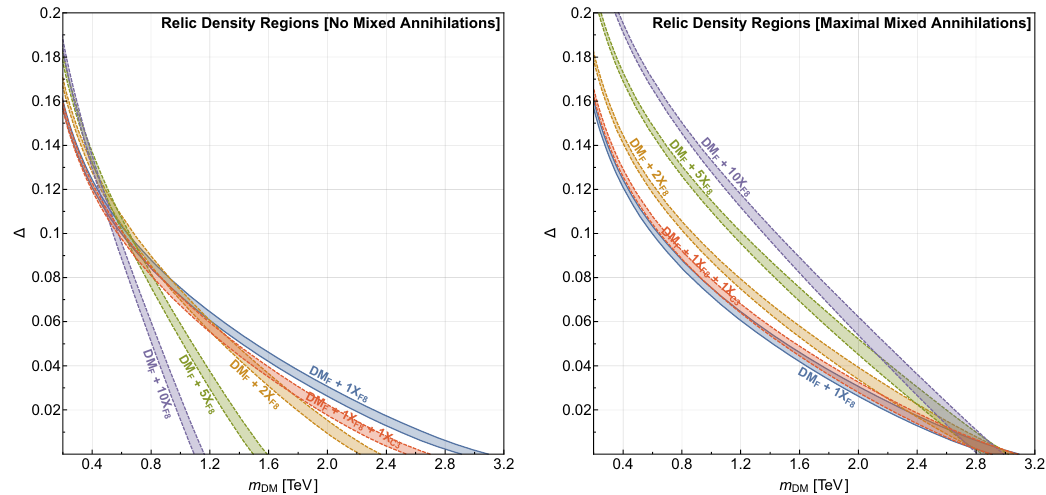
Figure 1 . Relic density constraints in the (cid:1) versus m DM plane for models where DM is a Dirac fermion. We show the parameter space regions that agree with the relic abundance measured by Planck. We compare models with multiple coannihilation partners against the benchmark model with a single partner X F8 (solid blue line). We either increase the multiplicity of X F8 or introduce an additional partner X C3 . The left (cid:12)gure shows the contours in the absence of mixed annihila- tion channels, while the right (cid:12)gure shows the models with the mixed annihilation cross-section saturating condition